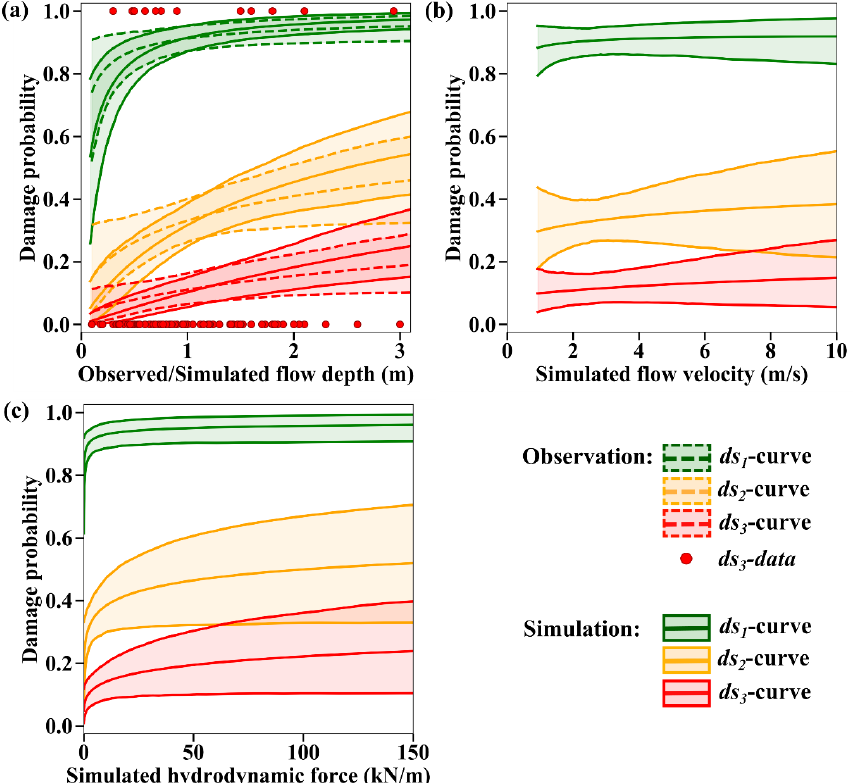
Figure 15. The 2018 Sulawesi–Palu curves for confined masonry buildings. Best-estimate fragility curves, with their 90% confidence in- tervals, as functions of (a) the observed and the maximum simulated flow depths, (b) the maximum simulated flow velocity, and (c) the simulated hydrodynamic force for confined masonry buildings with unreinforced clay brick of DB_Palu2018 sustaining partial damage repairable ( ds 1 ), partial damage unrepairable ( ds 2 ), and complete damage ( ds 3 ) in Palu